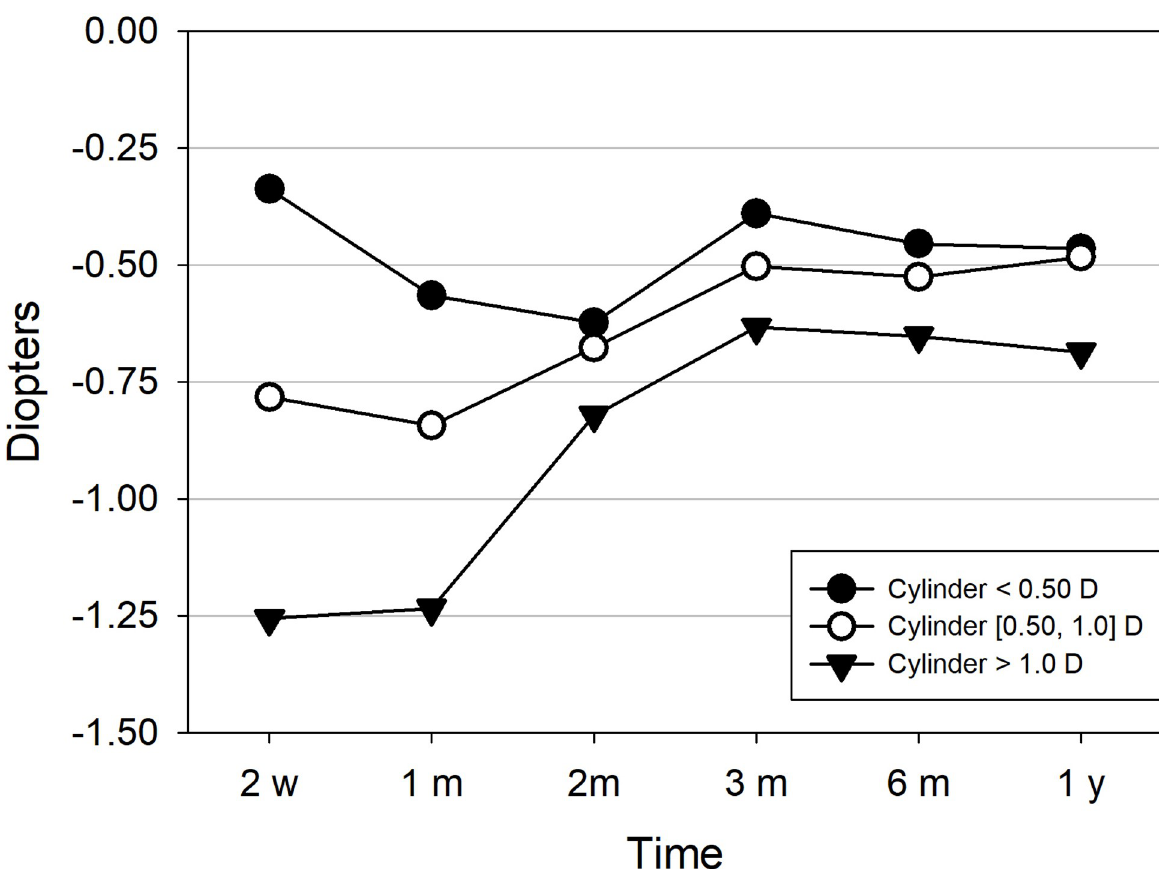
Fig 4. Mean values of induced cylinder for eyes grouped according 2-weeks post-surgery induced cylinder in cornea: less than 0.5 D (black circles. Sample: 6 eyes), between 0.5 and 1.0 D (white circles. Sample: 16 eyes) and higher than 1.0 D (triangles. Sample: 5 eyes), at all follow-ups.